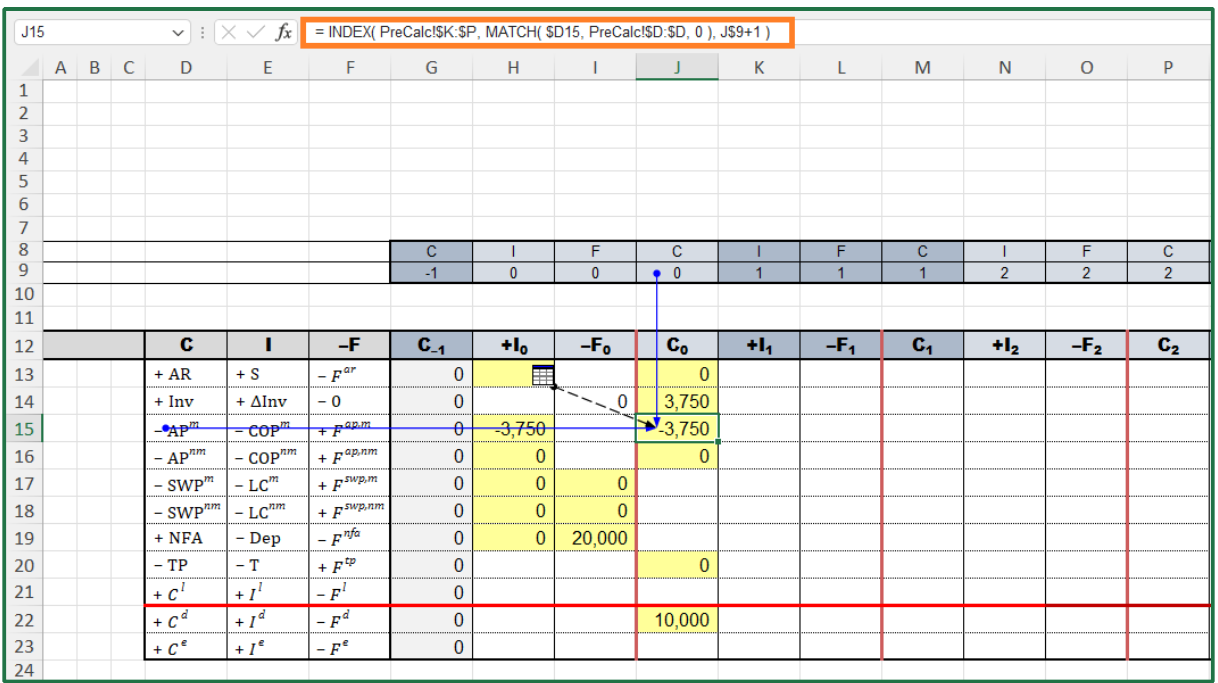
Figure 11. Cell K43 contains the value that has the same label of SplitScreenStrip!E13 and that is in the (H$9 + 1)-th column (“PreCalc” sheet).